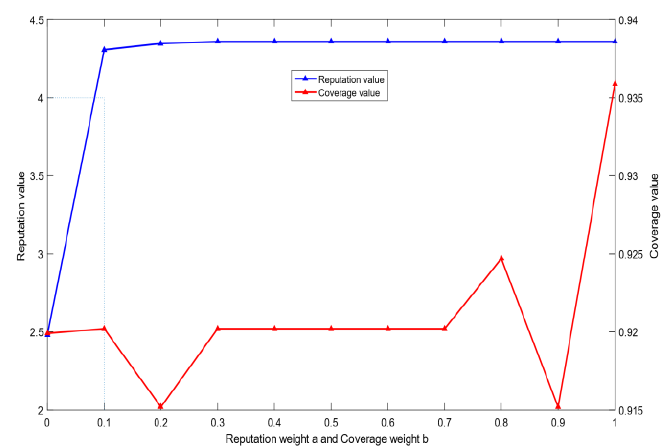
Figure 5. Change reputation and coverage with their weight.